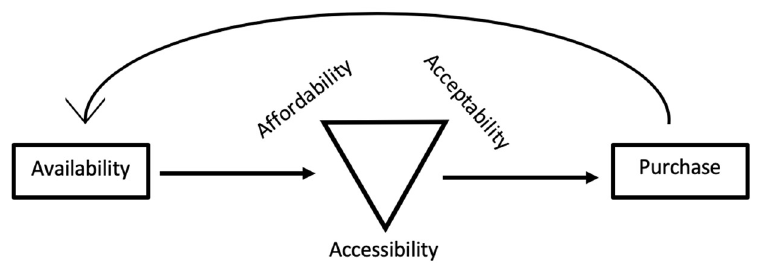
Figure 1. Hierarchy of decision-making and feedback loop in the food environment.